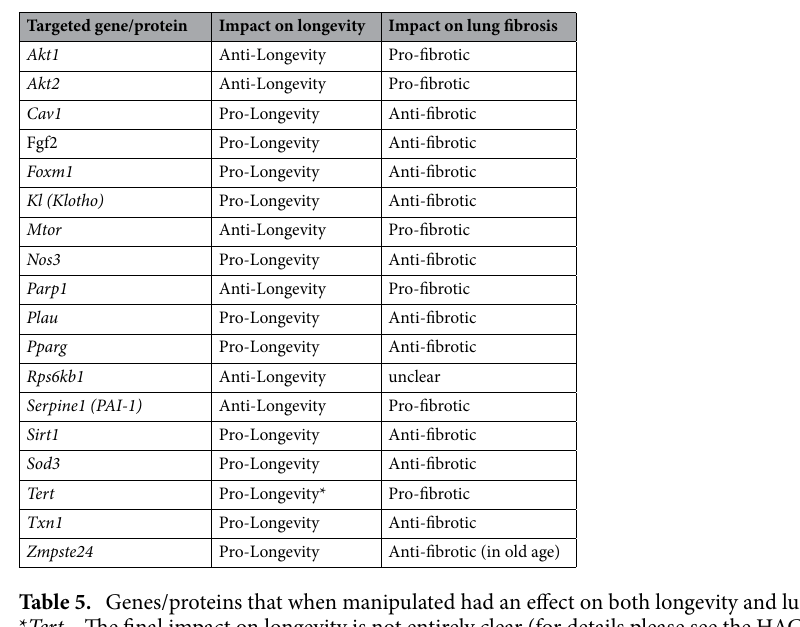
Table 5. Genes/proteins that when manipulated had an effect on both longevity and lung fibrosis in mice. * Tert —The final impact on longevity is not entirely clear (for details please see the HAGR—GenAge database for details; https:// genom ics. senes cence. info/ genes/ index. html). For detailed description, see Suppl. Table ST8.